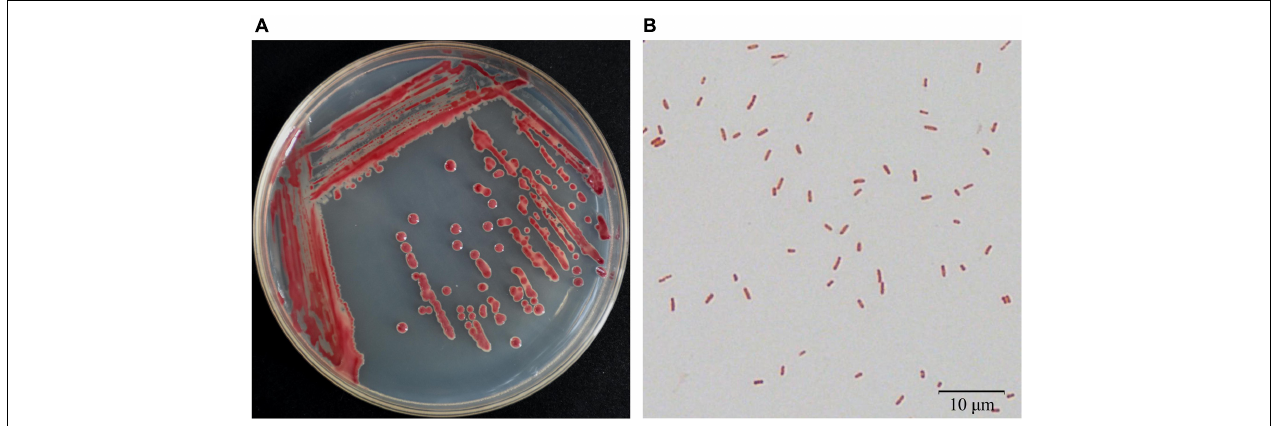
FIGURE 1 | Morphological characteristics of strain Pa82. (A) Colony appearance on TTC medium; (B) Cell morphology under 100 × oil-immersion objective lens (1,000 × total magnification).